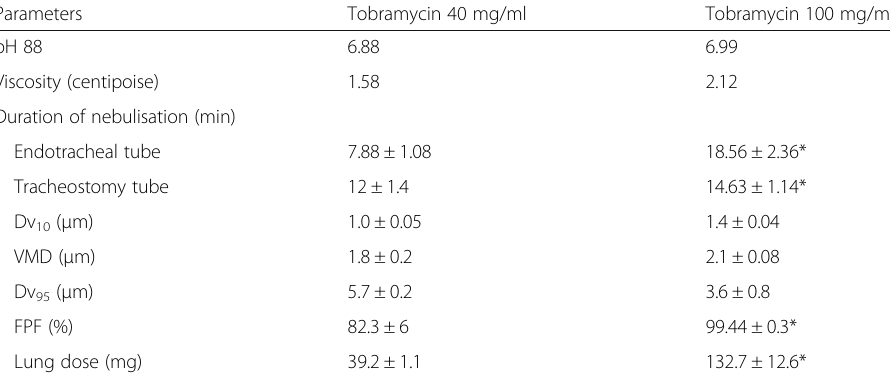
Table 2 Comparative characteristics between tobramycin 40 and 100 mg/ml solutions